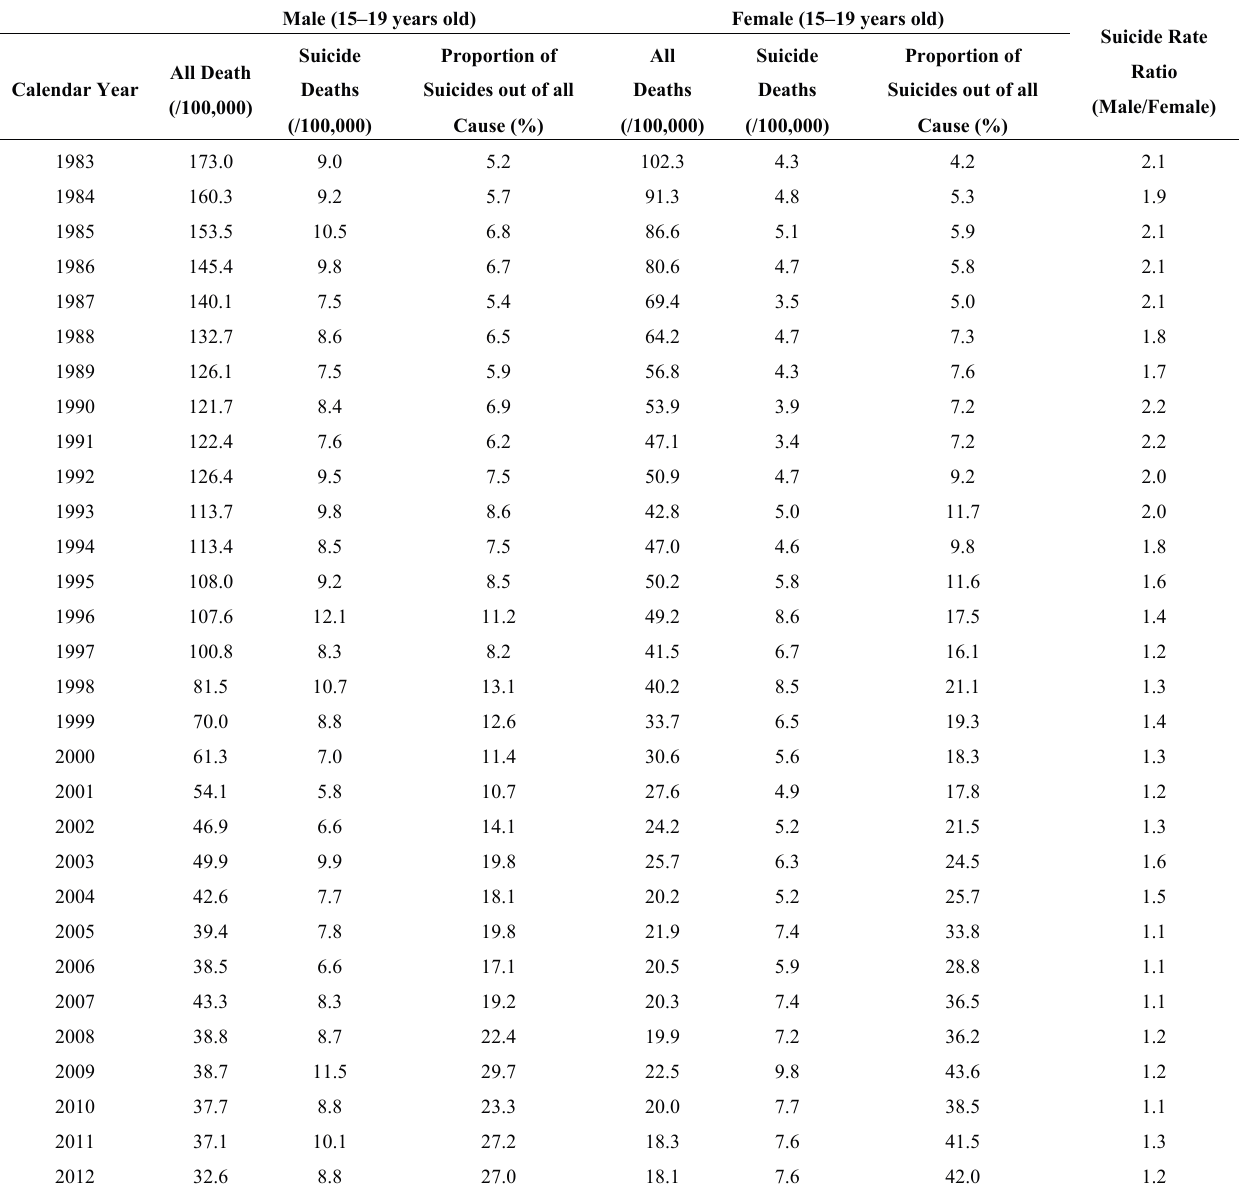
Table 1. Suicide death and death from all causes among adolescents (15 – 19 years of age) by gender in Korea,